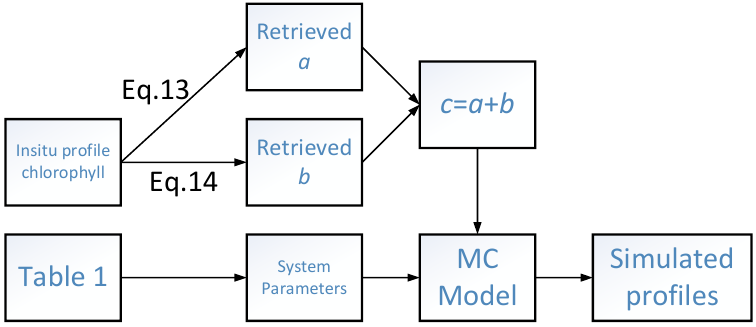
Figure 12. Diagram of in situ profile chlorophyll processing with Monte Carlo (MC) simulations.